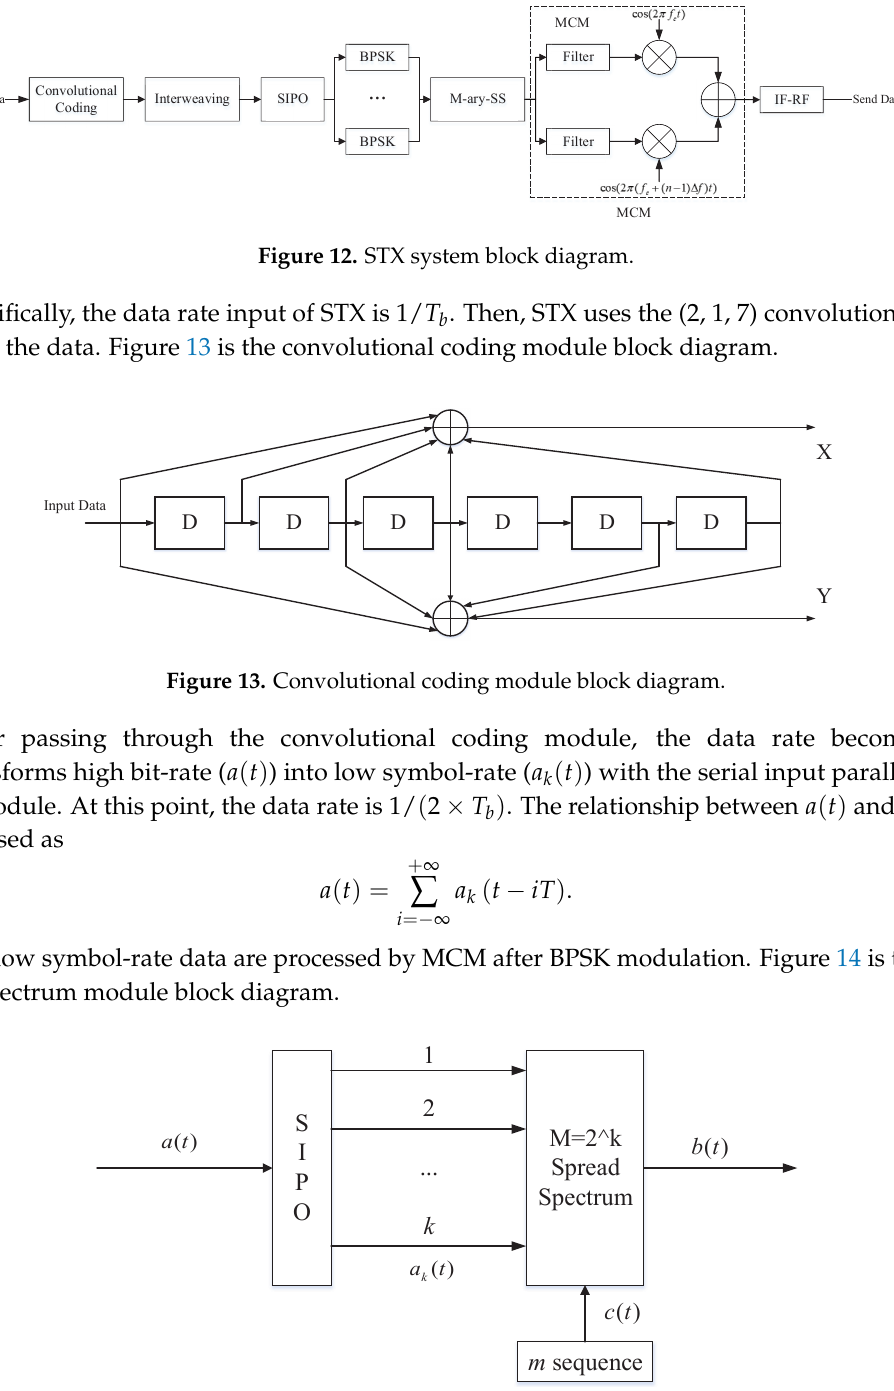
Figure 14. M-ary spread spectrum module block